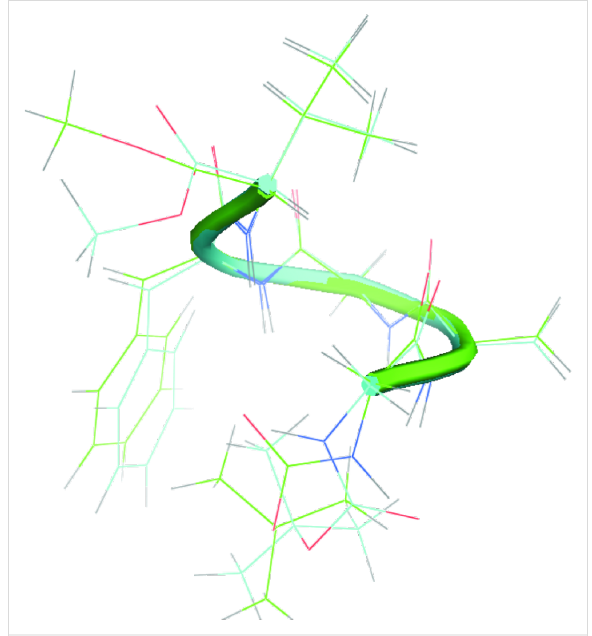
Figure 4: Proposal of the most stable conformation of peptide 3 based on XPLOR-NIH